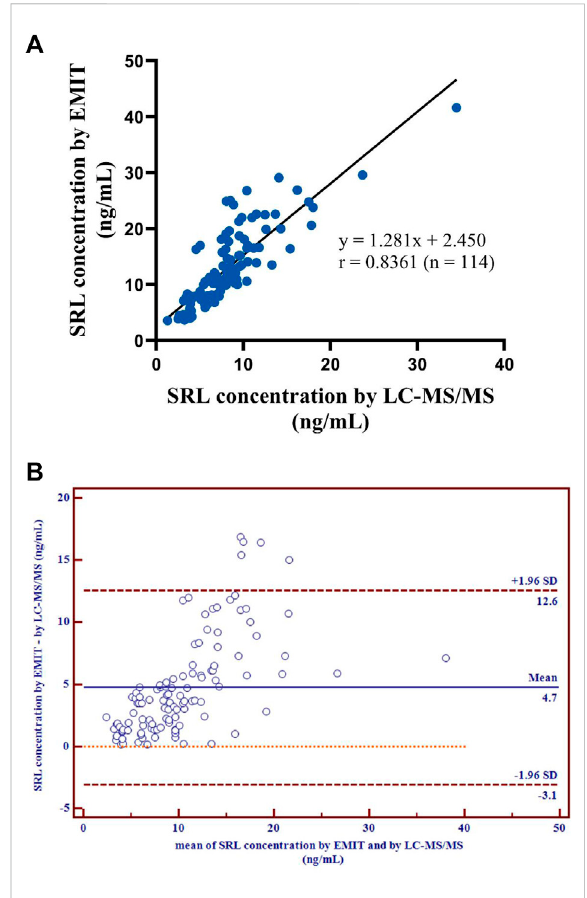
Correlation of the regression curve for LC-MS/MS and EMIT assay ( n = 114) (A) . Differences between mean whole blood SRL concentrations(ng/ml)generatedbyLC-MS/MSandbyEMITassay expressed as absolute bias ( n = 114) (B)